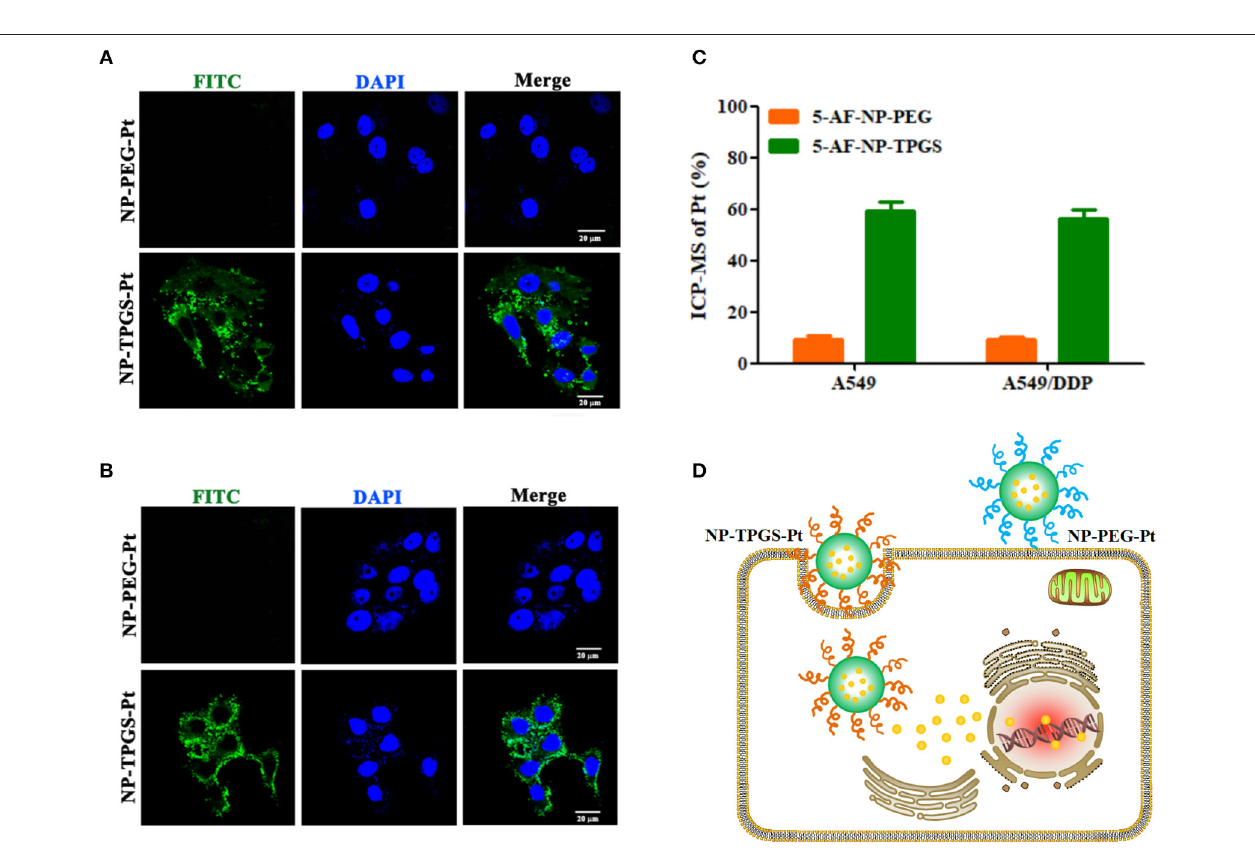
three Oxaliplatin formulations were significantly boosted, to those of Oxaliplatin and NP-PEG-Pt ( Figure 7B ).